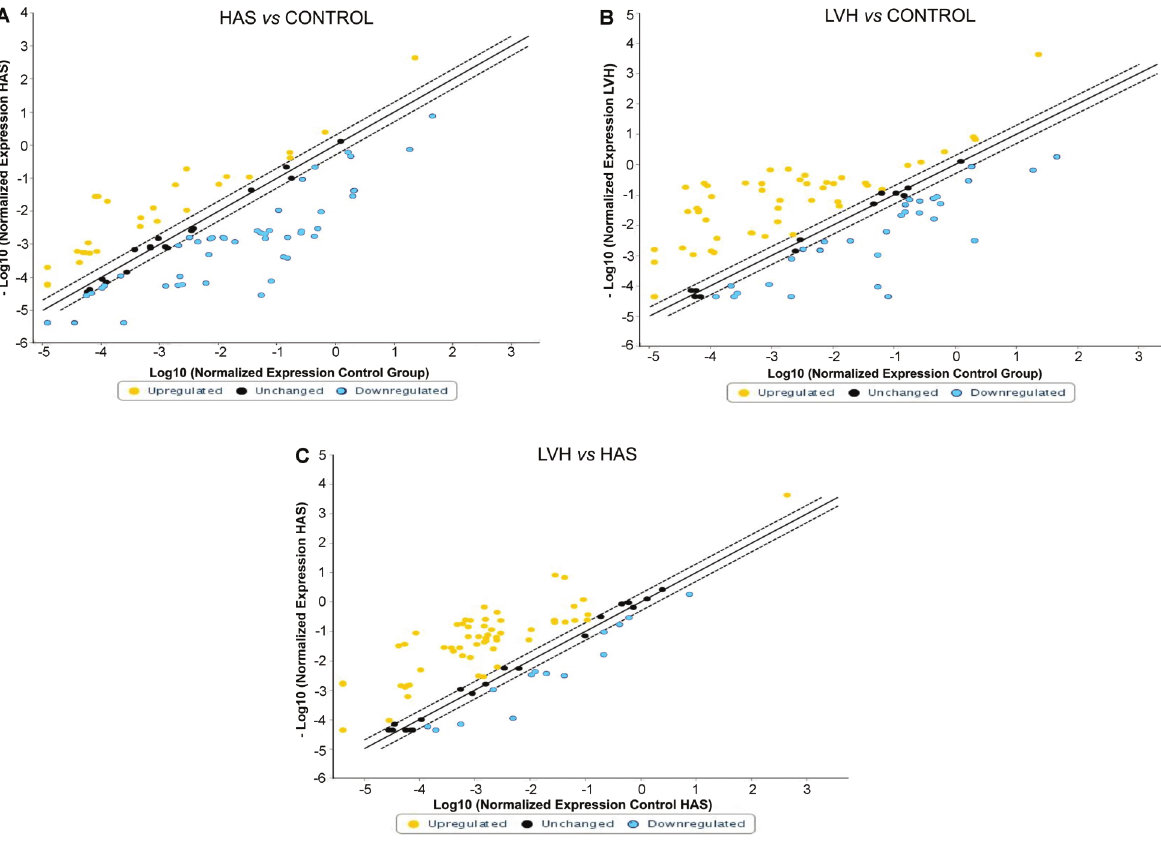
Figure 2. miRNAs differentially expressed in A , hypertensive patients without left ventricular hypertrophy (HAS) and control subjects; B , hypertensive patients with left ventricular hypertrophy (LVH) and control subjects and C , hypertensive patients with left ventricular hypertrophy (LVH) and hypertensive patients without left ventricular hypertrophy (HAS). The scatter plots illustrated miRNAs differentially expressed: dots in black indicate the miRNAs that did not reach signi fi cant changes of expression; dots in yellow indicate the miRNAs that had signi fi cant upregulation of expression; and dots in blue indicate the miRNAs that had signi fi cant downregulation of expression.